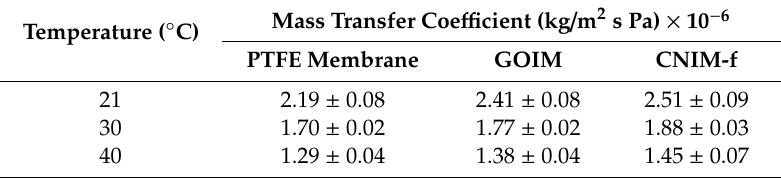
Table 1. Mass transfer coe ffi cient of 1.5% MTBE feed solution at various feed temperatures with a feed flow rate of 20 mL /